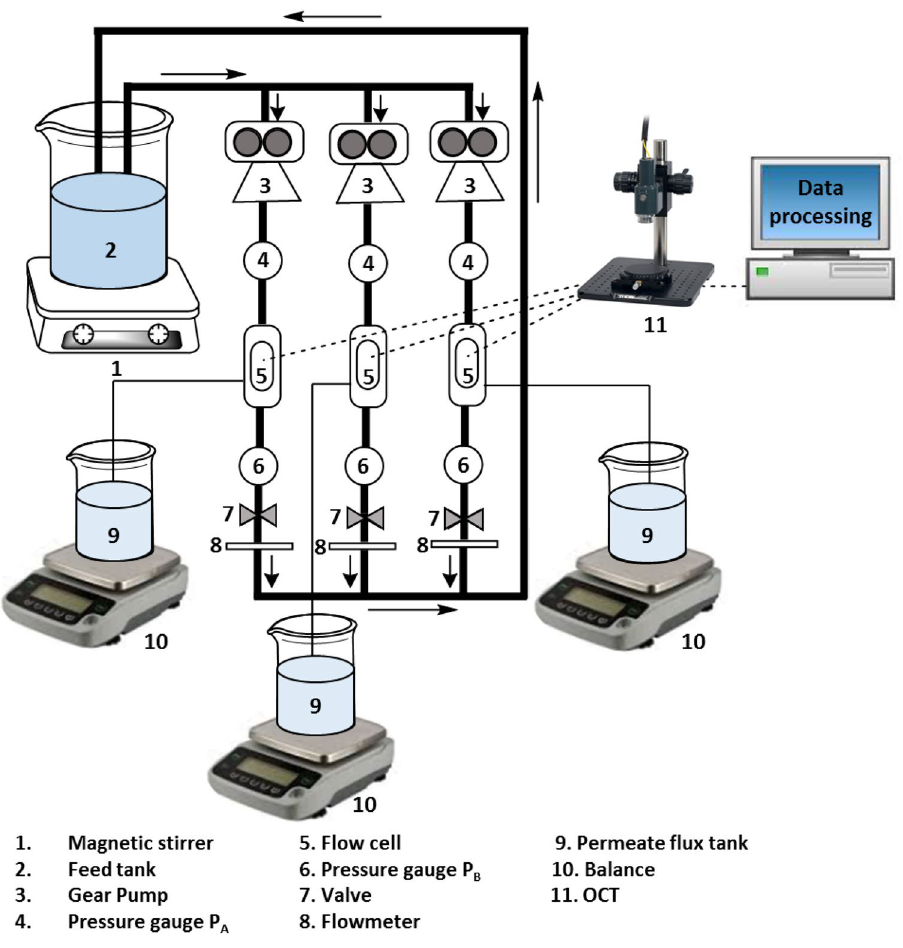
Figure 2. Schematics describing the lab-scale setup and the various instruments utilized for the lab-scale UF experiments. All experiments were performed for 67 h that were sufficient for all spacers to reach the steady- state condition (stable permeate flux) of